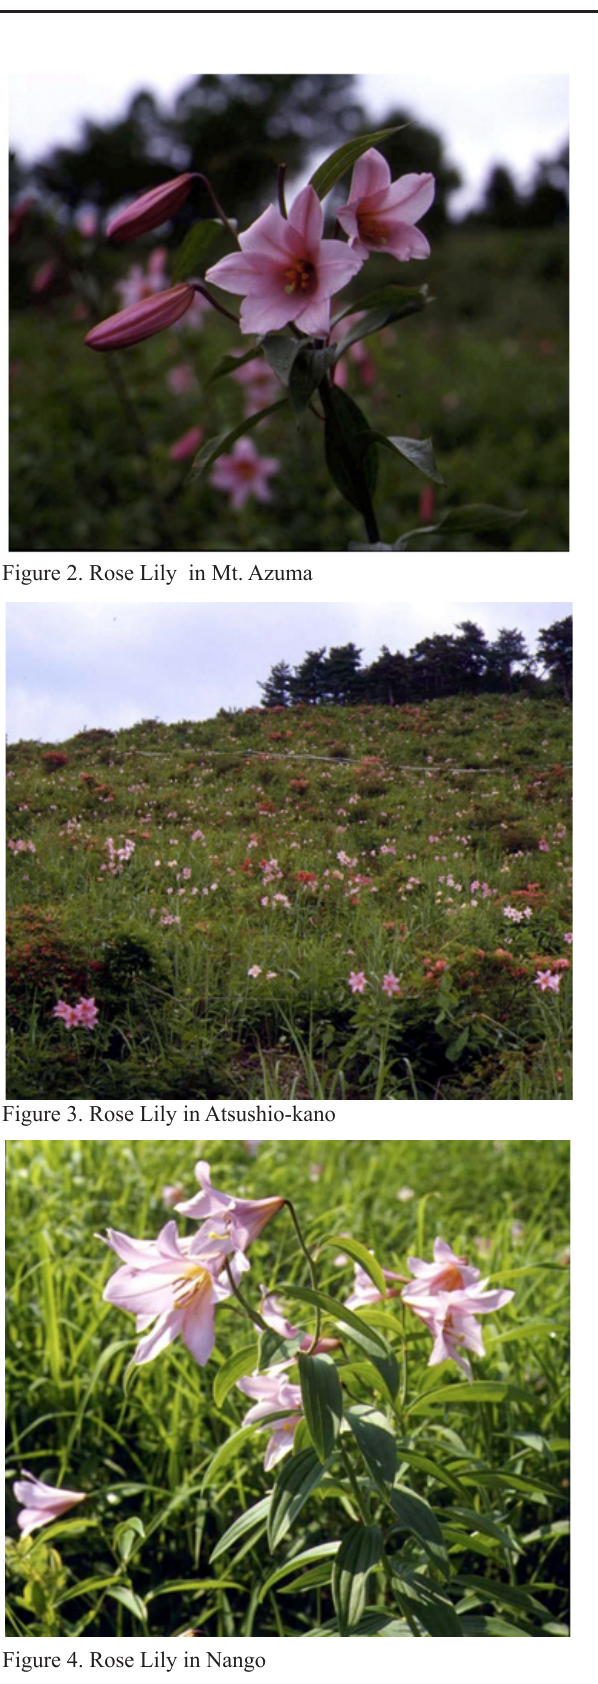
Figure 4. Rose Lily in Nango DNA extraction Total DNA was extracted by the CTAB method (Murray &